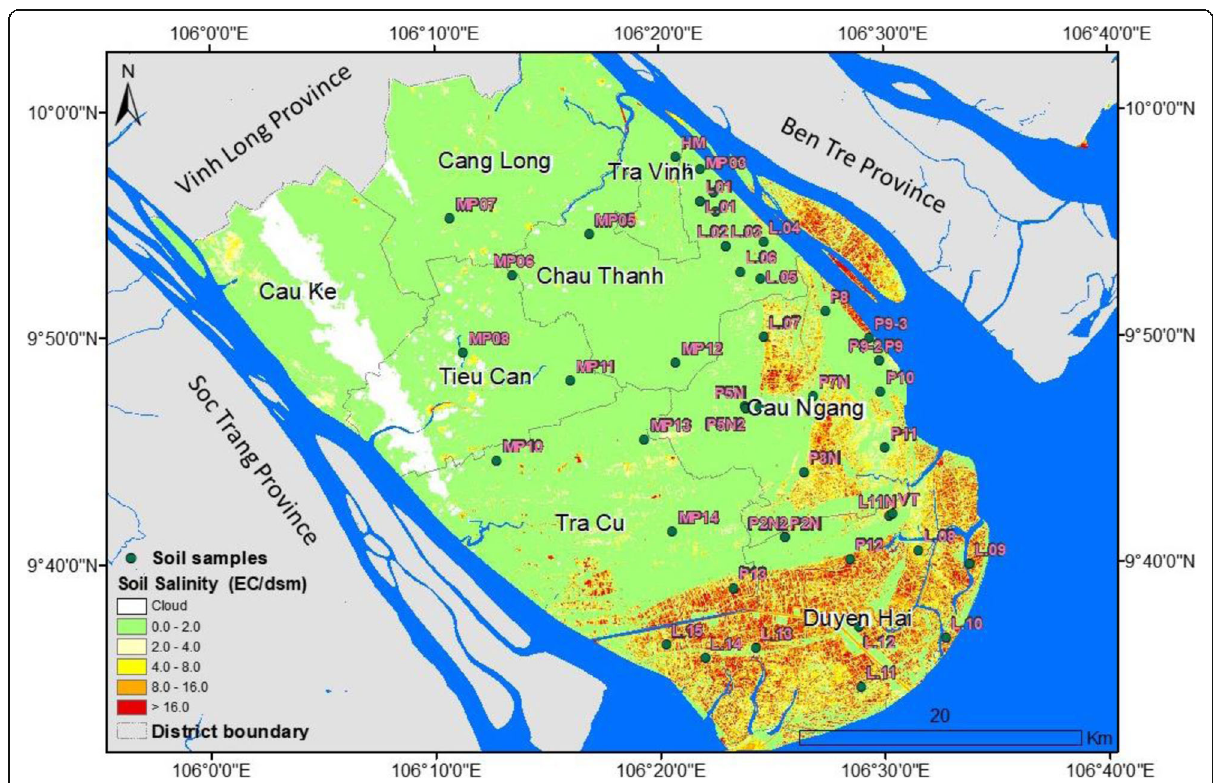
Fig. 11 Soil salinity map with depth from 0 to 20 cm, using model VSSI index in Tra Vinh Province (equation 6 in Table